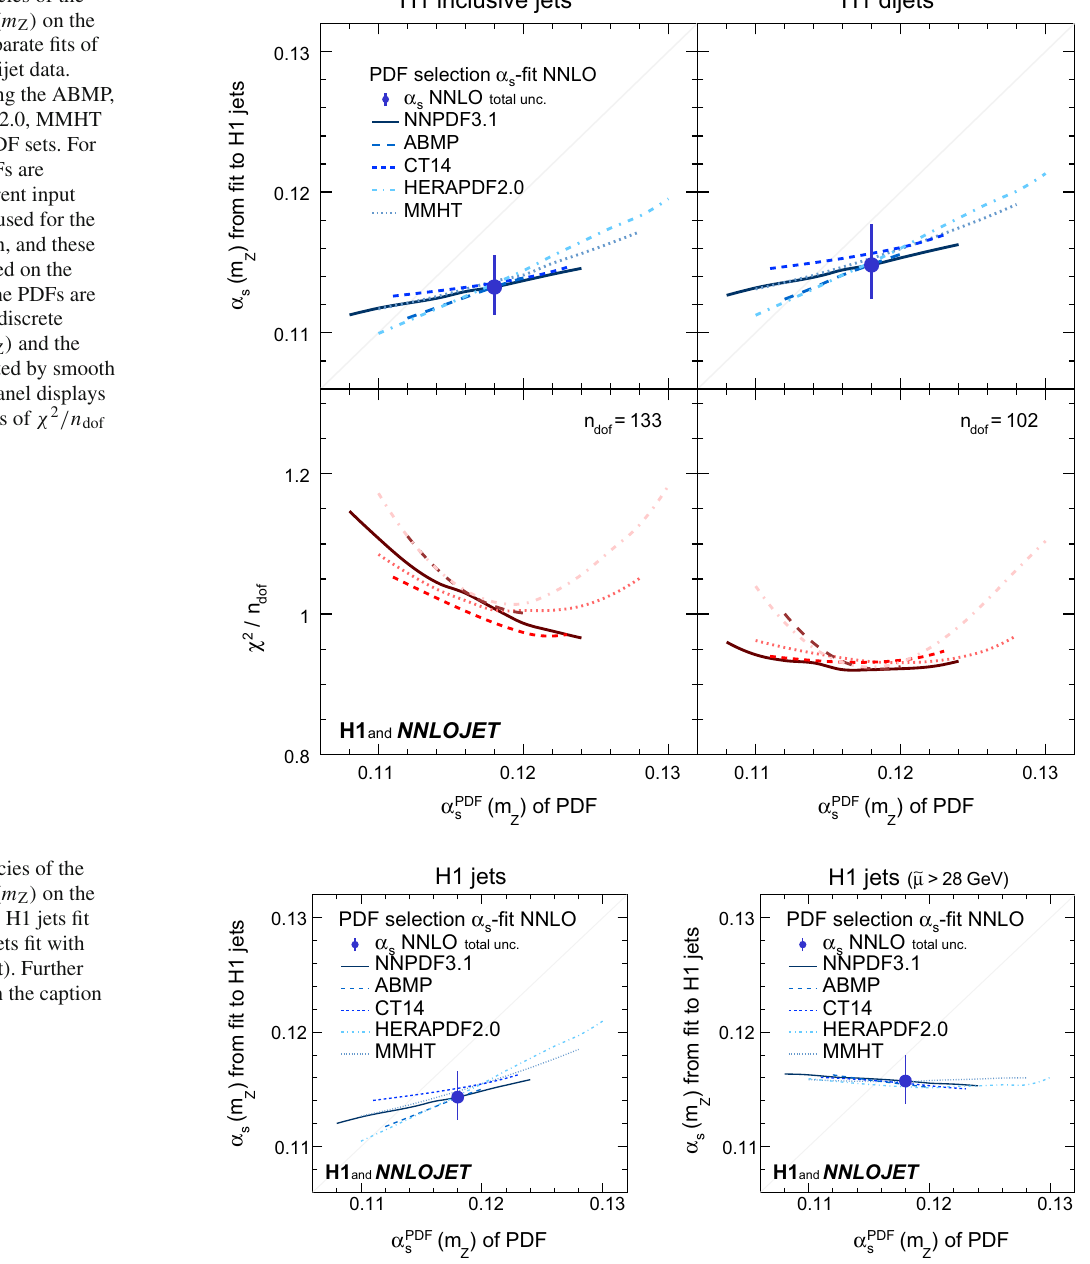
Fig. 4 Dependencies of the fitted values of α s ( m Z ) on the input PDFs for separate fits of inclusive jet and dijet data. Shown are fits using the ABMP, CT14, HERAPDF2.0, MMHT and NNPDF3.1 PDF sets. For each case, the PDFs are available for different input values α PDF s ( m Z ) used for the PDF determination, and these values are displayed on the horizontal axis. The PDFs are available only for discrete values of α PDF s ( m Z ) and the results are connected by smooth lines. The lower panel displays the resulting values of χ 2 / n dof of the fits